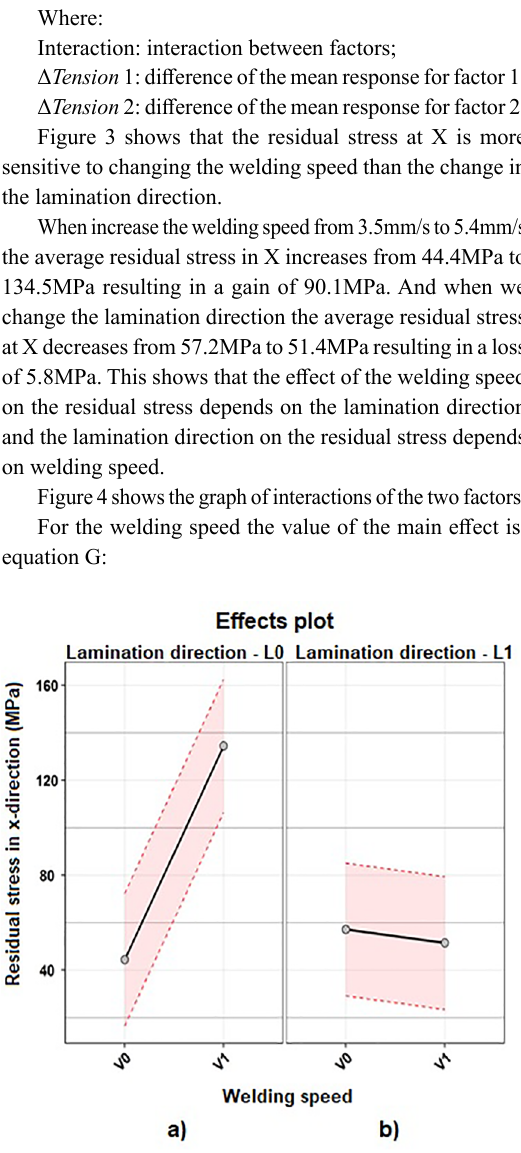
Figure 3. Graph of effects of welding speed and lamination direction a)L0 and b)L1 in the residual stress in